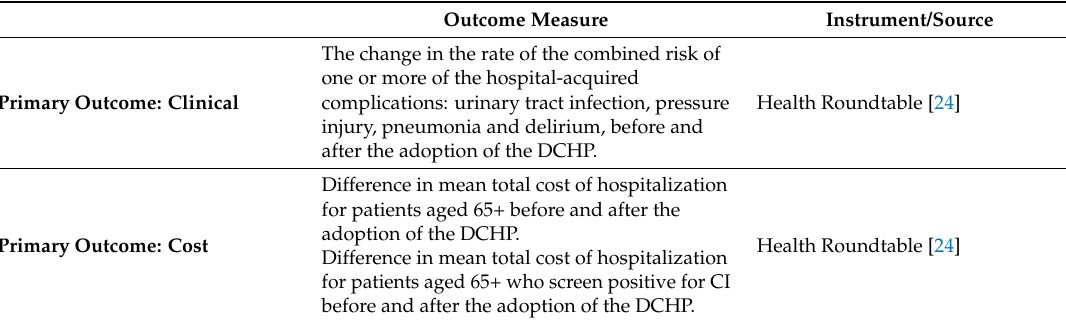
Table 3. Outcome measure, instruments and data